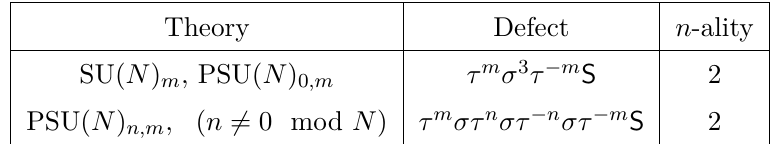
Table 5 . Non-invertible symmetries of su ( N ) with N prime and N ≥ 3 at τ YM = i .